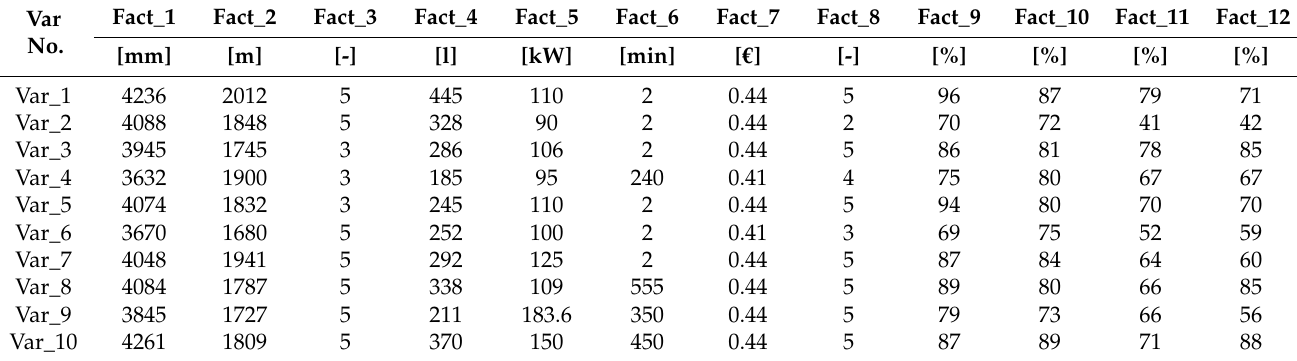
Table 3. A detailed set of criteria characterizing individual variants of car